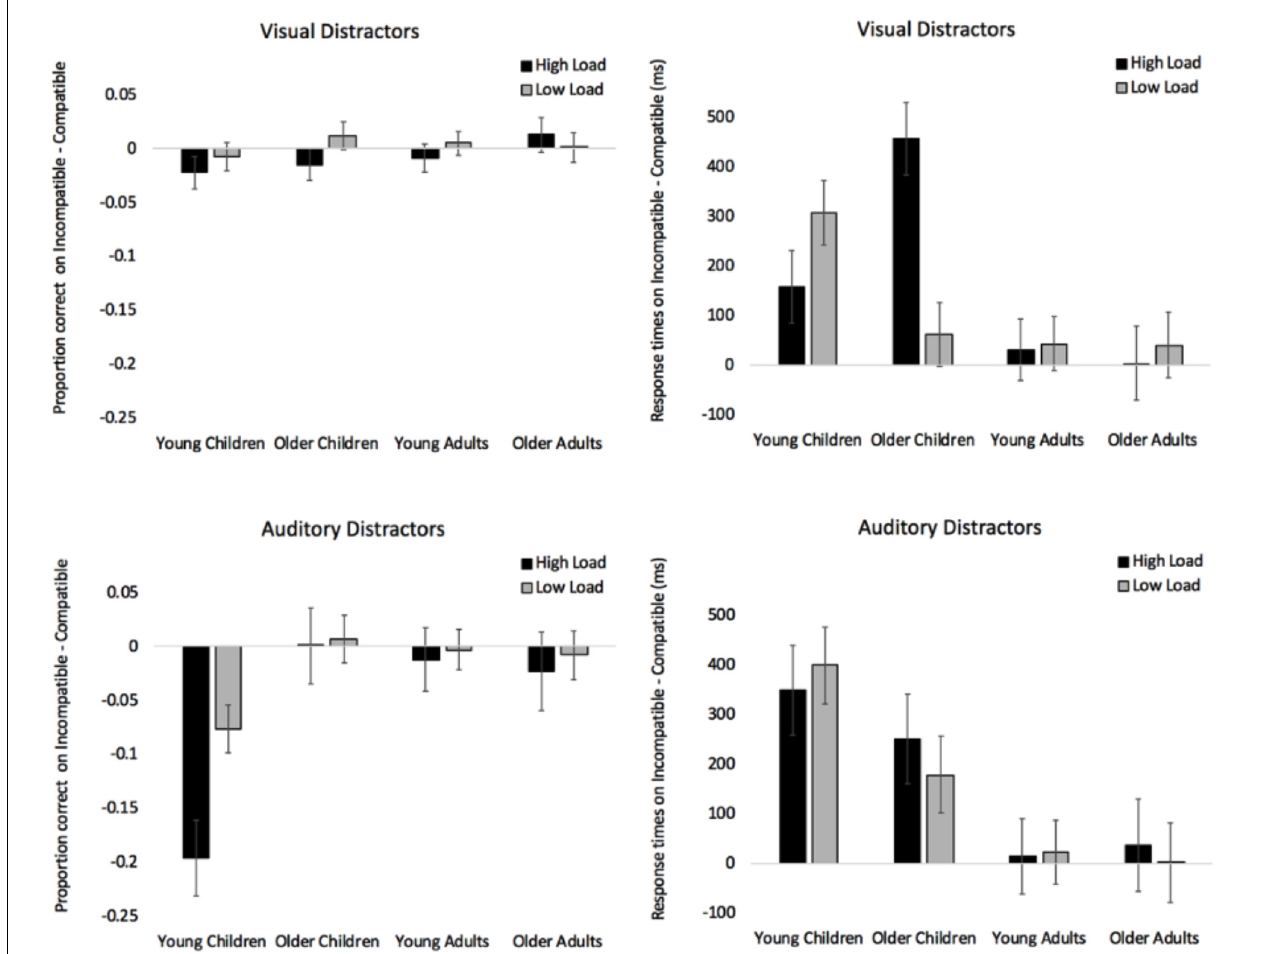
FIGURE 2 | Proportion of correct responses on incompatible trials – compatible trials when presented with visual distractors (top left) and auditory distractors (bottom left). Response times on incompatible trials – compatible trials when presented with visual distractors (top right) and auditory distractors (bottom right). Error bars denote Standard